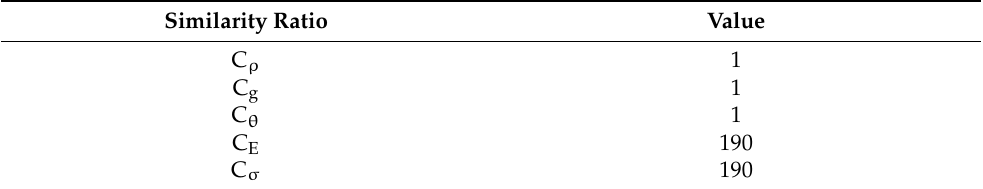
Figure 4. Schematic diagram of the modeling process ( a – f ). Table 3. Similarity ratios.